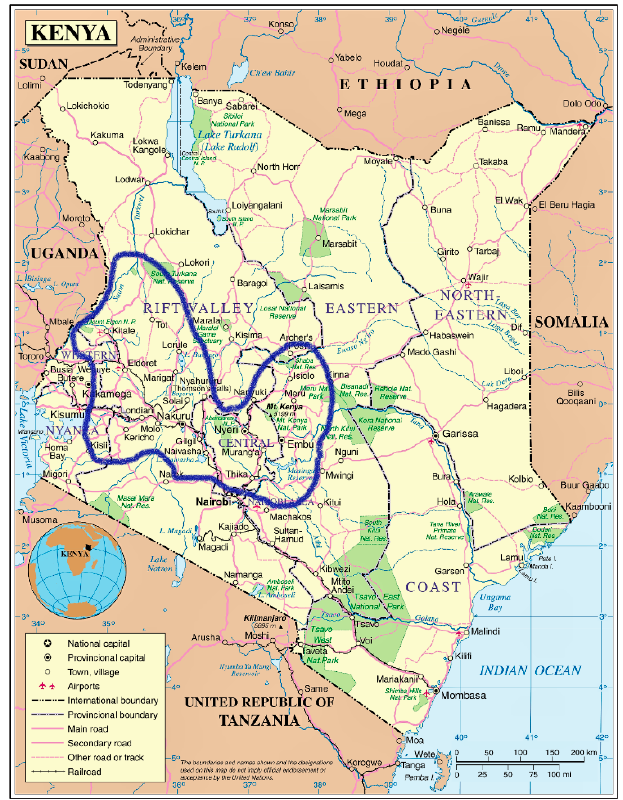
Figure 1. Map of Kenya showing high potential regions for wool sheep breeds.